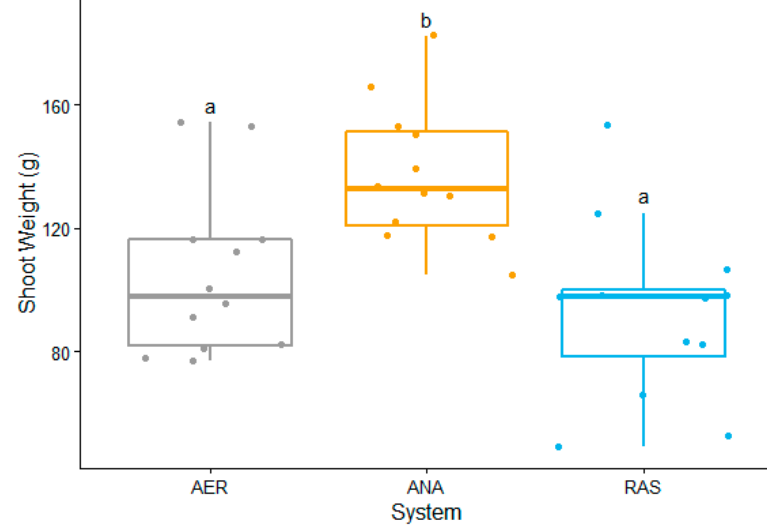
Figure 6. Lettuce shoot fresh weight in the aerobic (AER), anaerobic (ANA), and RAS systems after 35 days. Different letters indicate significant differences (Tukey’s HSD, n = 12, p < 05). Descriptive statistical data of this box plot can be found in Table 3.